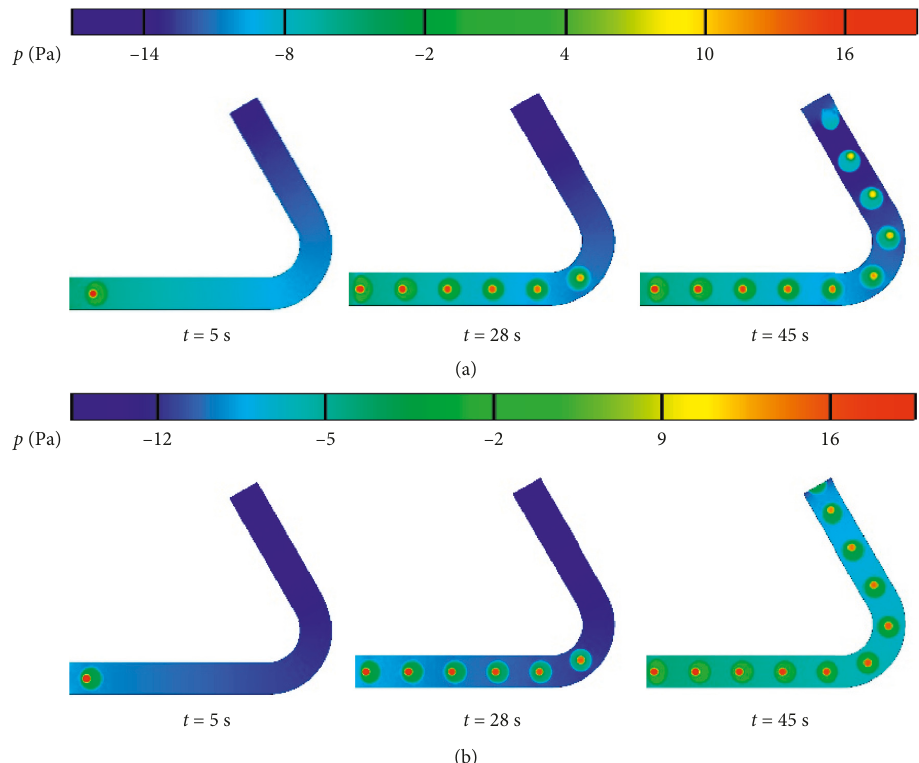
Figure 9: Effect of capillary number on the pressure distribution during compound droplet deformation: (a) Ca � 0.05; (b) Ca �